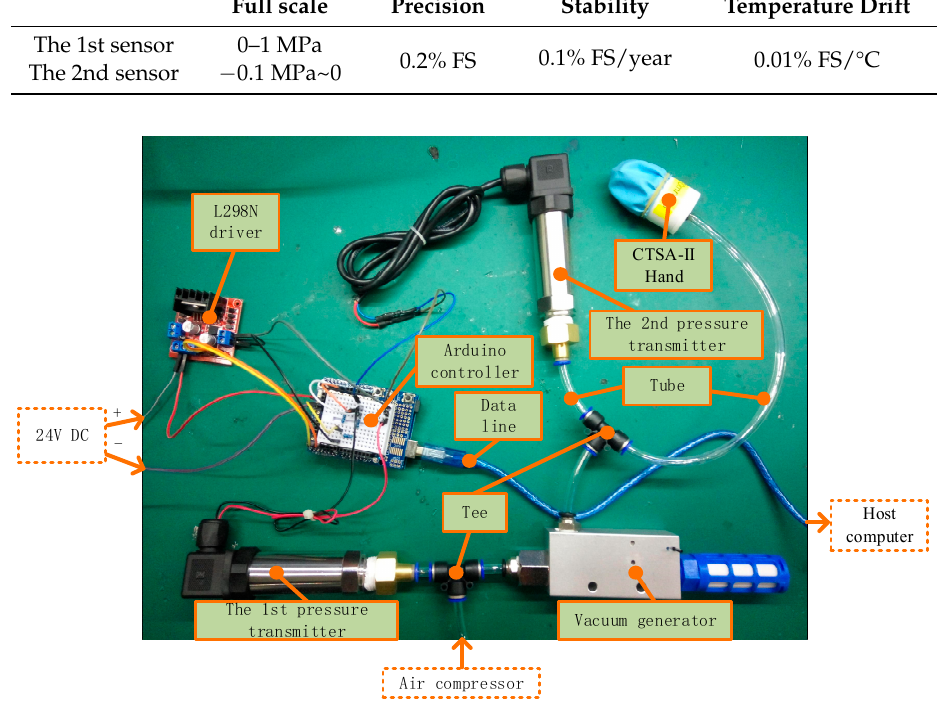
Figure 17. The experimental platform of exploring pressure.